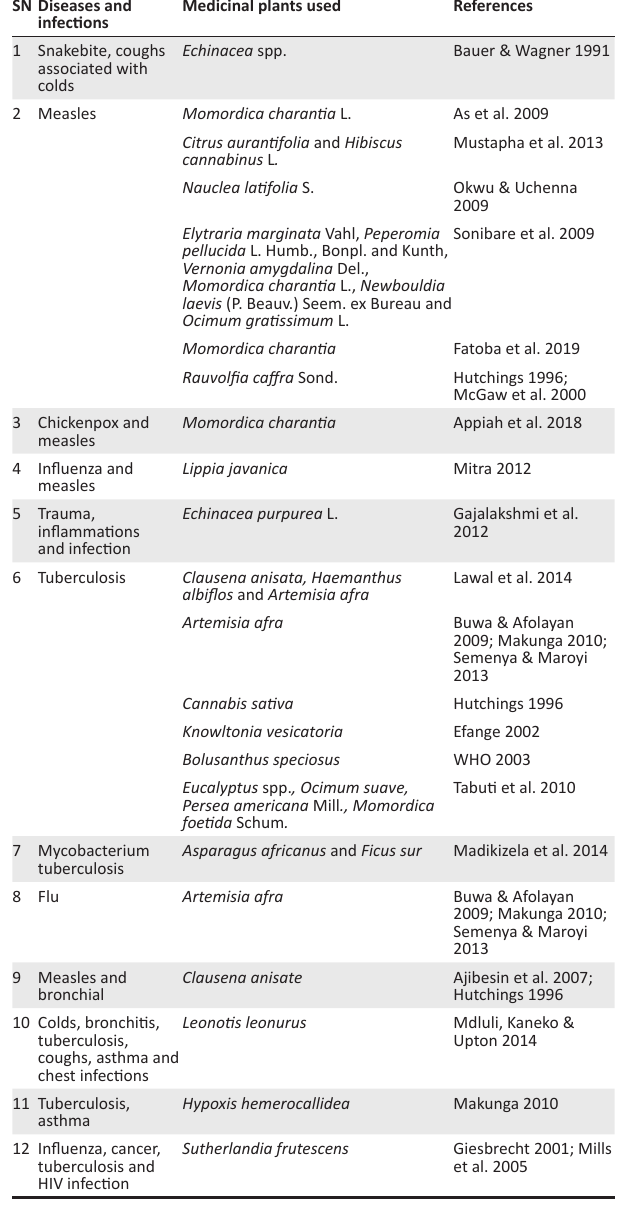
TABLE 2: Summary of some diseases and infections currently being treated with medicinal